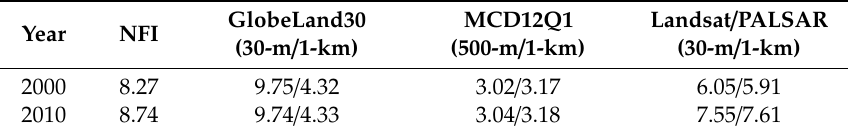
Table 3. Comparison of the forest area (unit: 10 6 ha) of three datasets with di ff erent resolutions in 2000 and 2010 in Guangdong